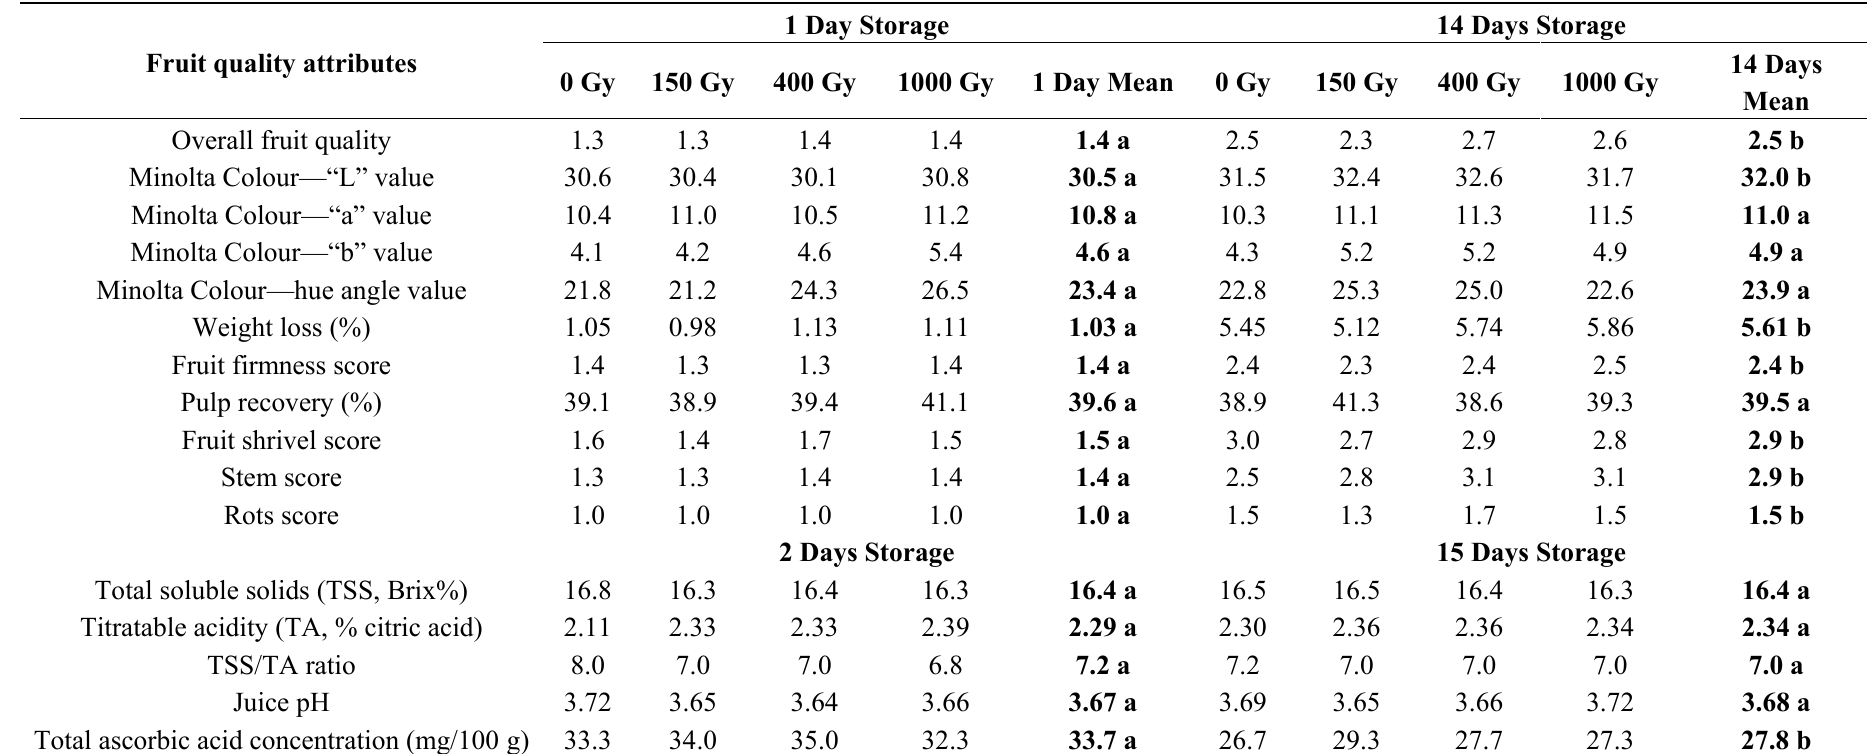
Table 3. Effect of storage and irradiation treatment (0, 150, 400 and 1000 Gy) on the fruit quality and total ascorbic acid concentration of “Sweetheart” passionfruit stored for one (or two) and fourteen (or fifteen) days at 8 °C. Means with different letters within rows are significantly different ( p